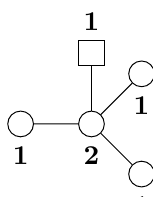
Figure 6 . The Coulomb branch of this quiver is isomorphic to the so (8 ; C ) minimal nilpotent